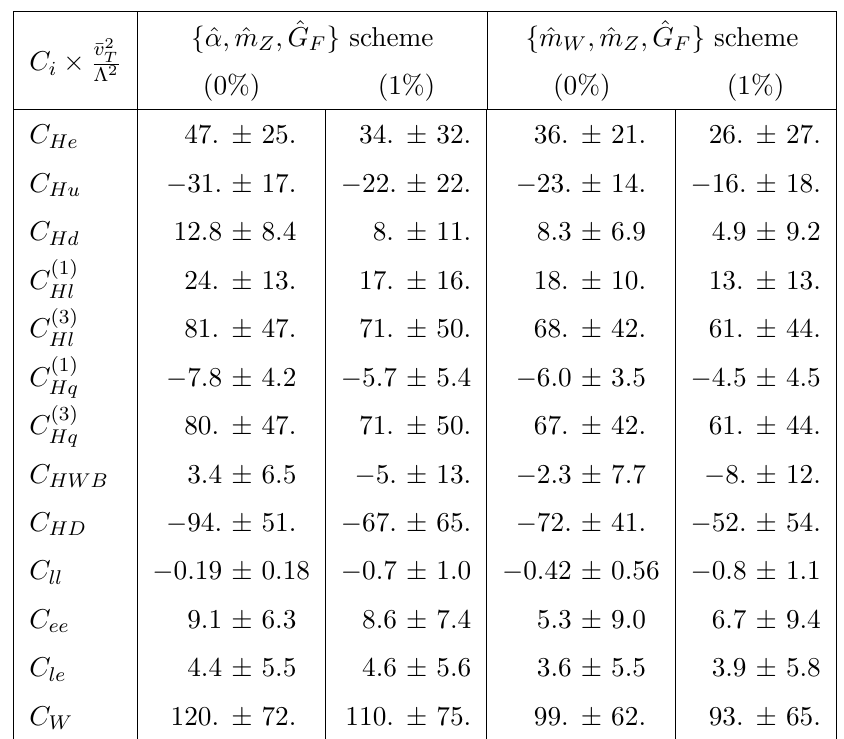
Table 5 . Best (cid:12)t values and corresponding 1 (cid:27) con(cid:12)dence regions for (cid:1) SMEFT = f 0% ; 1% g and for the two input parameter schemes considered in this work. The numbers have been obtaining after pro(cid:12)ling the (cid:31) 2 over the other parameters and they have been multiplied by a factor 100.